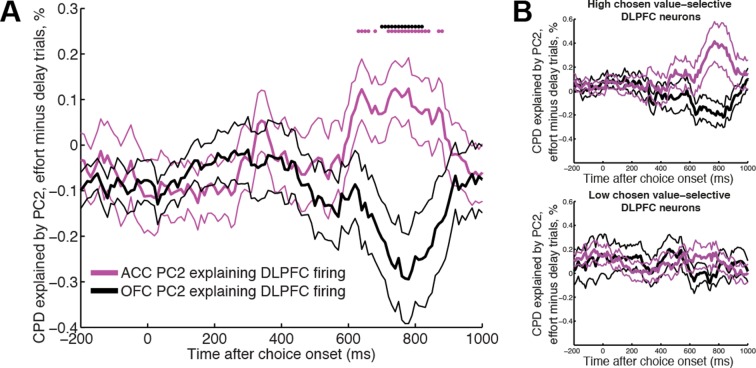
ACC and OFC local dynamics explain greater DLPFC neural firing on effort-based and delay-based decisions, respectively.(A) The relative CPD for DLPFC firing explained by PC2 on effort trials minus delay trials, where PC2 is derived from simultaneously recorded ACC LFP (magenta) and OFC LFP (black) (n=124 DLPFC units which had simultaneous recordings in both OFC and ACC). ACC explains more variance on effort than delay trials (positive-going values), whereas the converse is true for OFC (negative-going values). See also Figure 5—figure supplement 1. Lines show mean /- s.e. across neurons. Dots denote timepoints with a significant (p<0.05, permutation test) change in CPD across the DLPFC population. (B) The same analysis as in Figure 5A, having first performed a median split for chosen value-selectivity. Neurons with high chosen value selectivity (top panel, n=62 DLPFC units) show the effect found in Figure 5A, whereas neurons with low chosen value selectivity (bottom panel, n= 62 DLPFC units) do not.